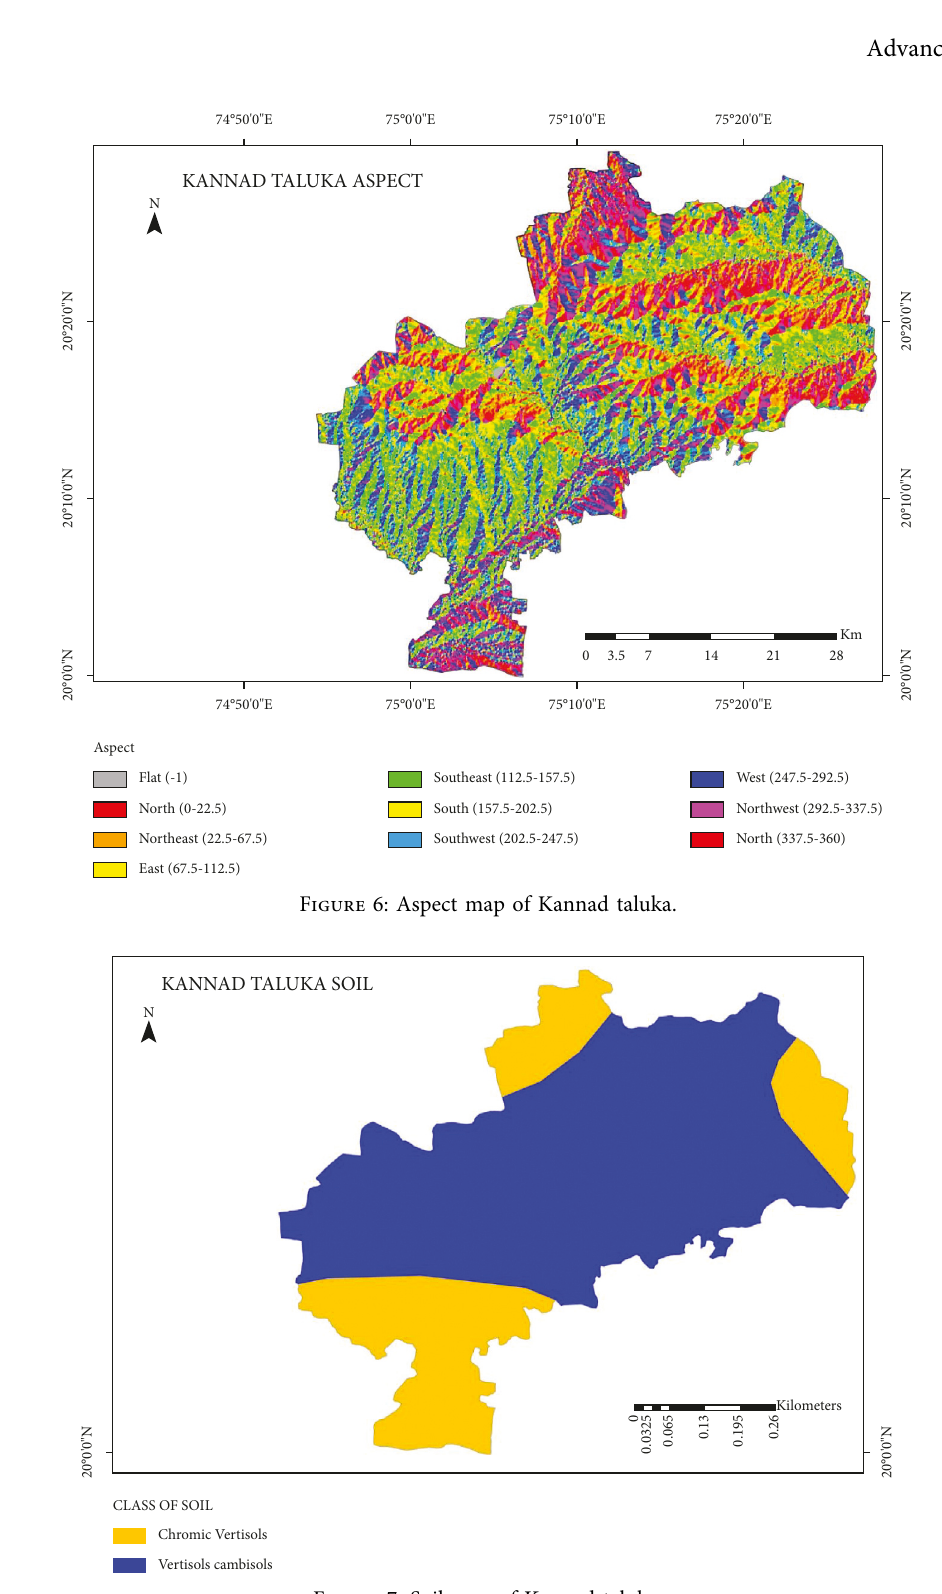
Figure 7: Soil map of Kannad